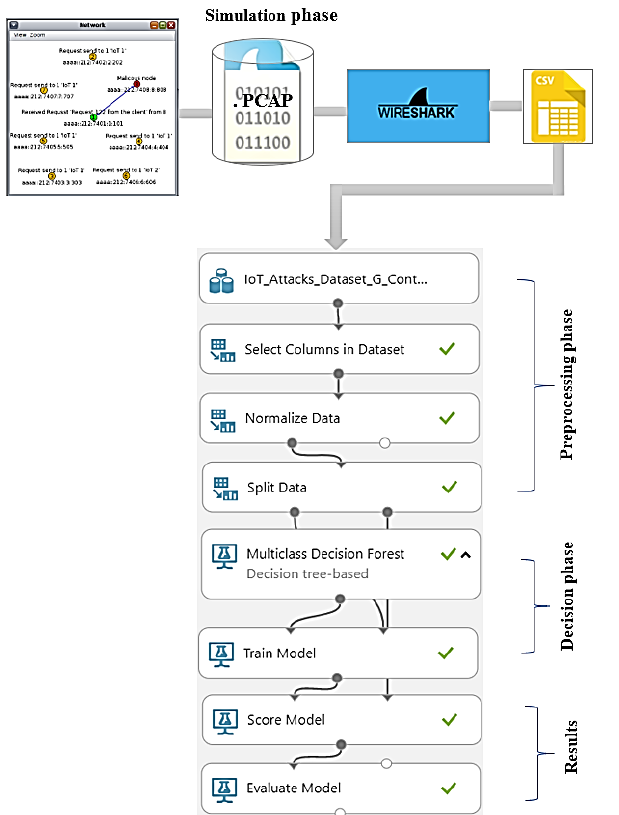
Figure 3 . Proposed model for detecting the IoT attacks